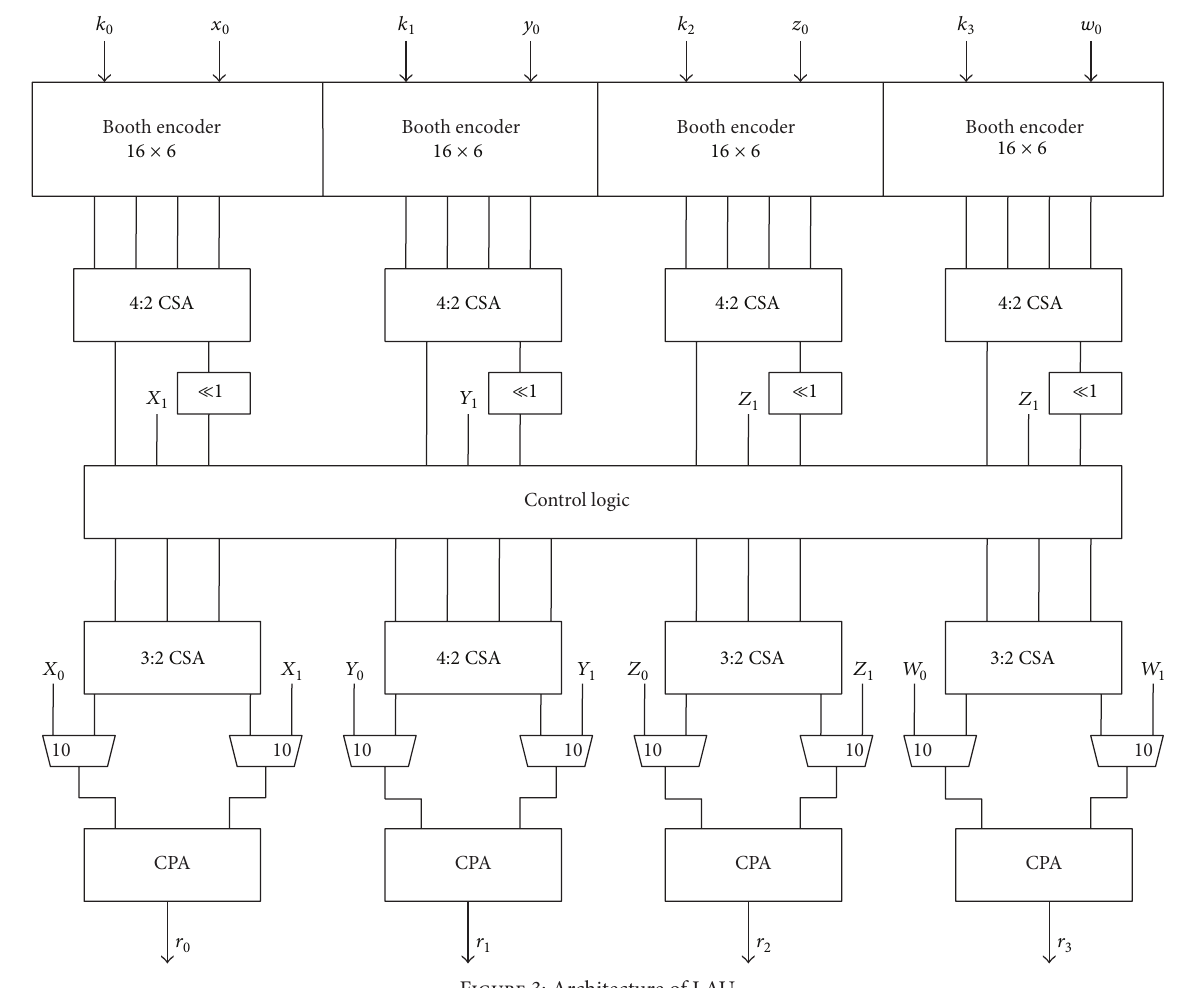
Figure 3: Architecture of